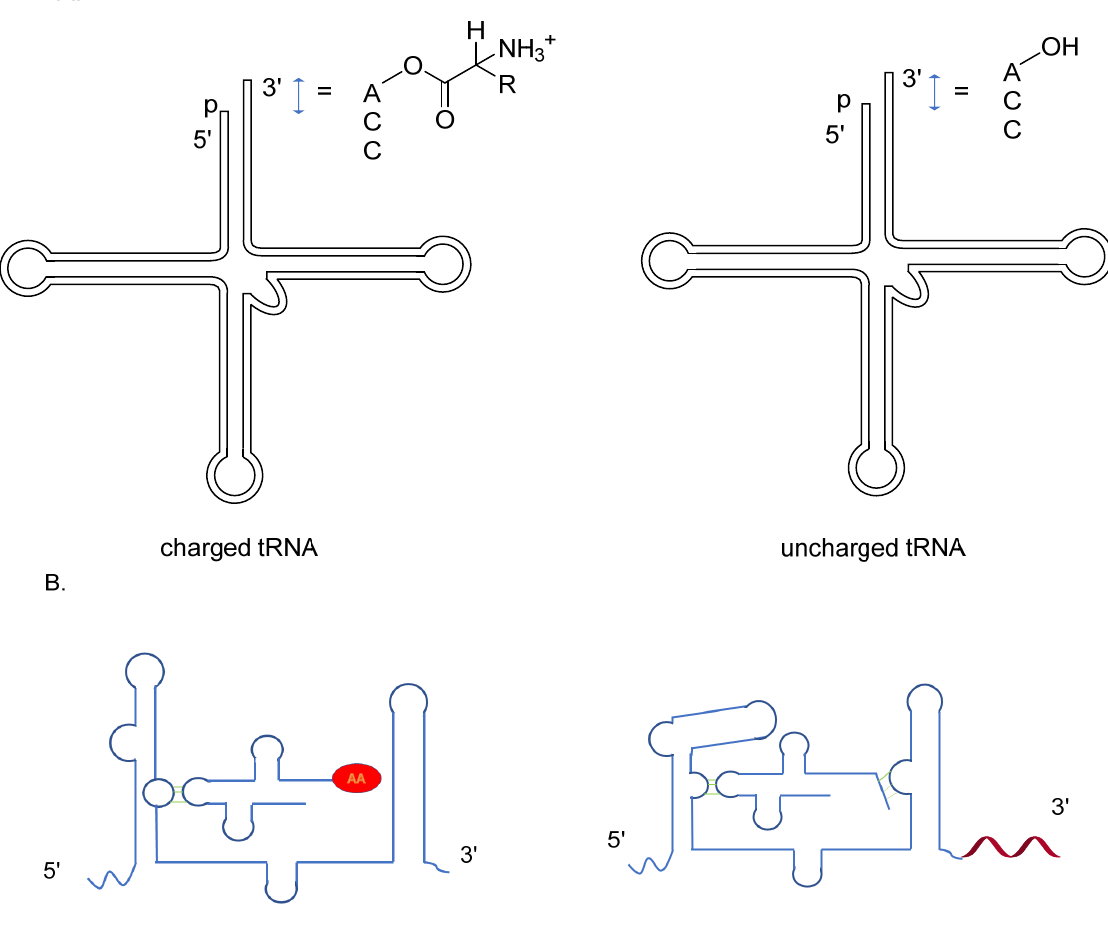
Figure 12. Structure of T-box riboswitch. ( A ) Both the charged and the uncharged tRNA has the CCA tail at the 3 ′ end. However, charged tRNA has an aminoacyl group rather than a hydroxyl group in uncharged tRNA. ( B ) Abundant of charged tRNA binds downstream of the riboswitch, stopping it from transcription. Conversely, uncharged tRNA binds with the T-box anti T/S region, and the conformational change upstream of the riboswitch promotes the formation of anti-terminator and proceeds with the transcription.